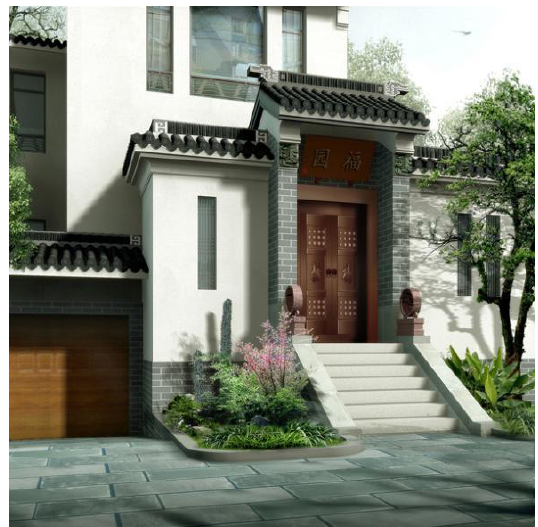
Figure 21. Traditional gate attached with modern garage at Suzhou Fuyuan villa estate. Source: Suzhou Guardian Real Estate Development Co. 2007